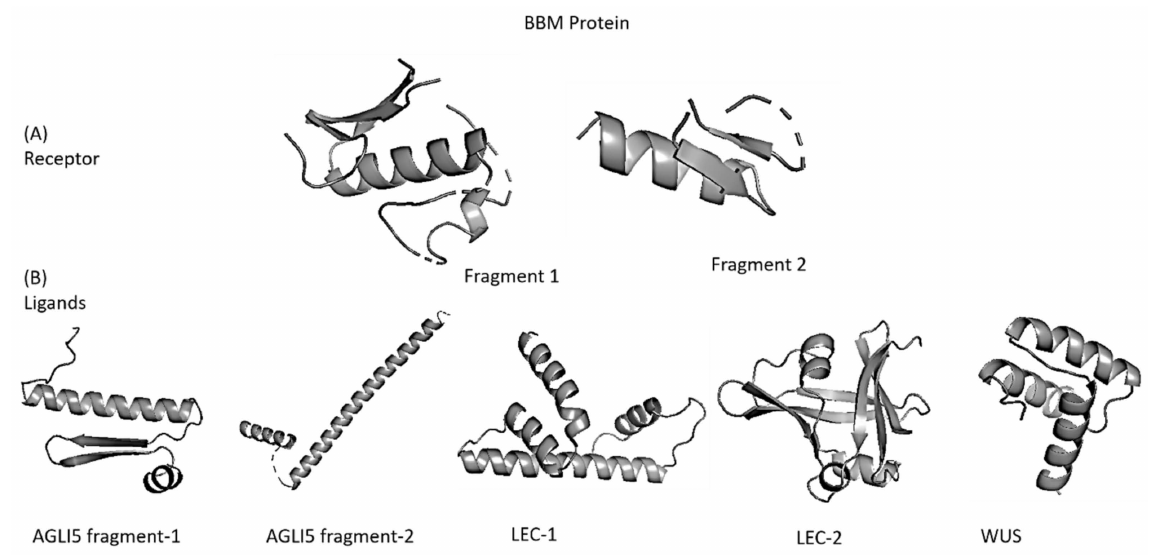
Figure 1. Fragments of BBM and its interacting partners that showed pLDDT > 90 on AlphaFold server used further for docking as ( A ) receptor and ( B )